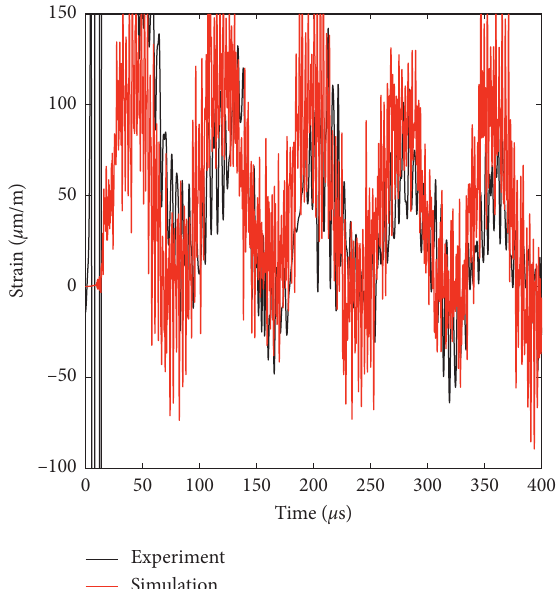
Figure 21: Longitudinal strain for shot 128 with a linear elastic model ( E � 220 GPa), plotted against experimental data measured at a length of 154mm on the bottom face of the second